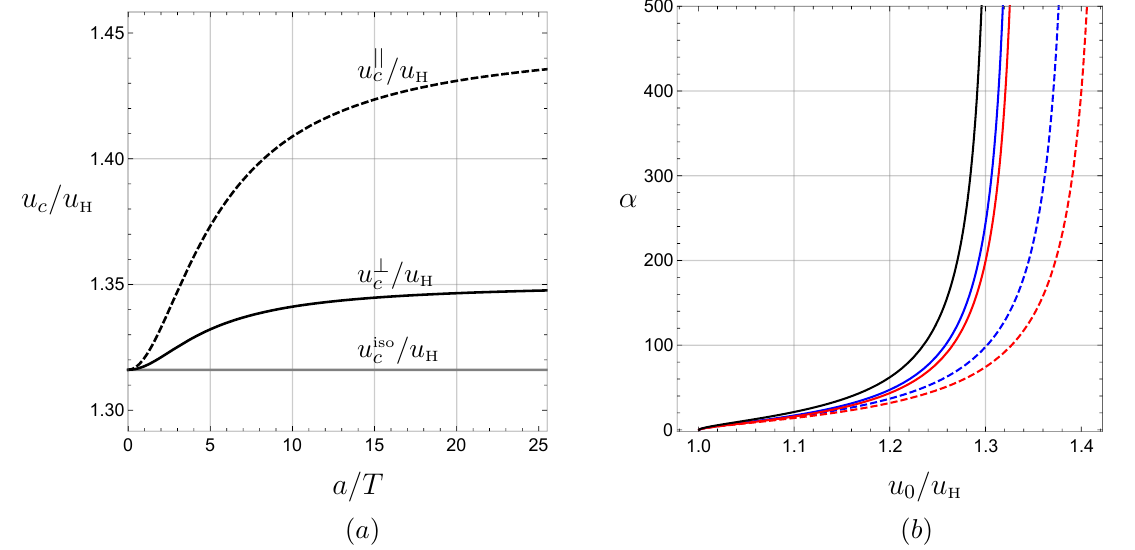
Figure 6 . (a) Critical point u c at which (cid:11) diverges as a function of the anisotropy parameter. The continuous curve represent the result for u ? , while the dashed curve represent the result for u jj c . c The horizontal gray curve is the result for the isotropic case u iso =u = 3 1 = 4 . (b) The shock wave H c parameter (cid:11) as a function of u 0 . The curves correspond from the left to the right to a=T = 0 (black curve), a=T = 8 : 56 (blue curves) and a=T = 21 : 57 (red curves). The continuous/dashed curves represent the result for a strip orthogonal/parallel to the anisotropic direction.